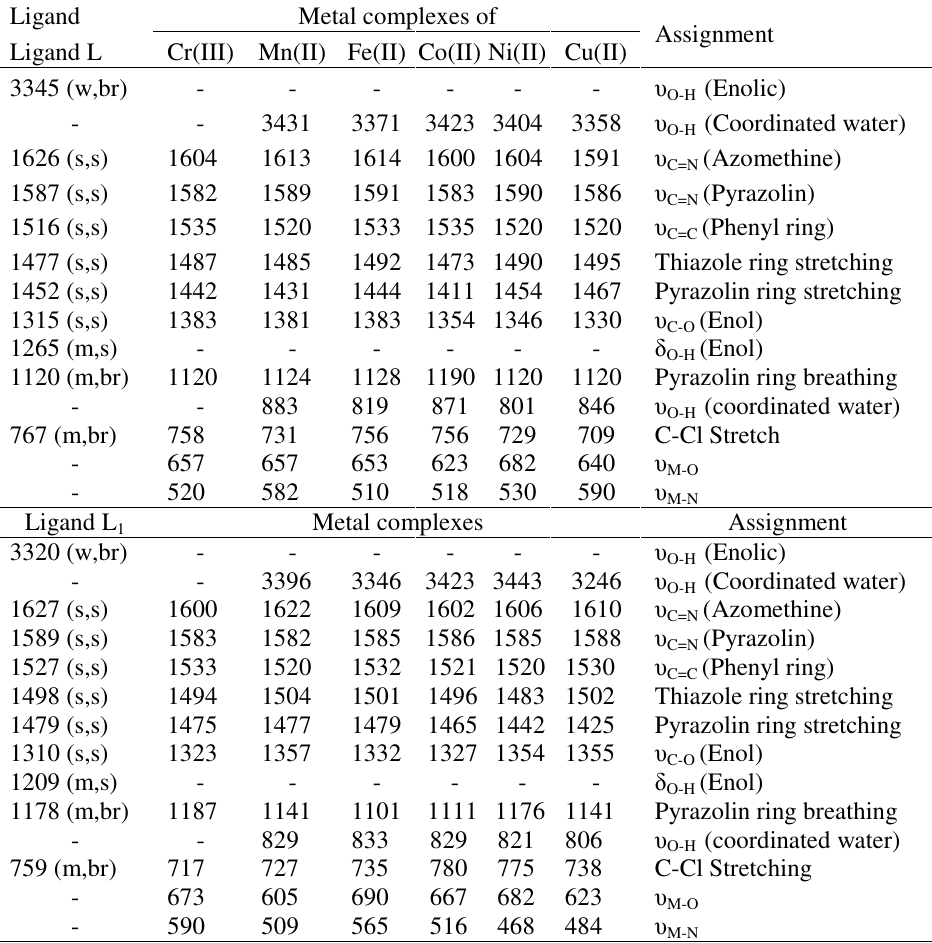
and its complexes 1